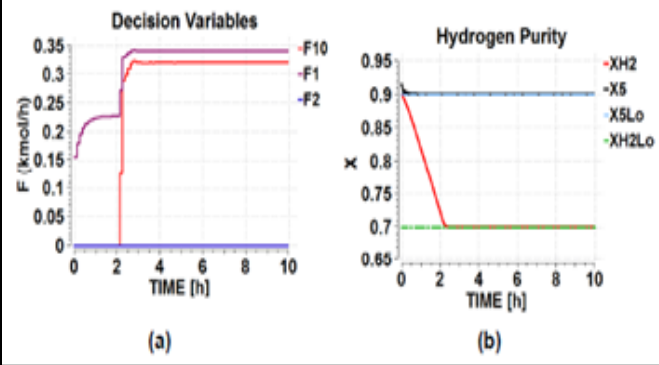
Figure 10: (a) Manipulated and (b) constrained variables. Source: Authors,